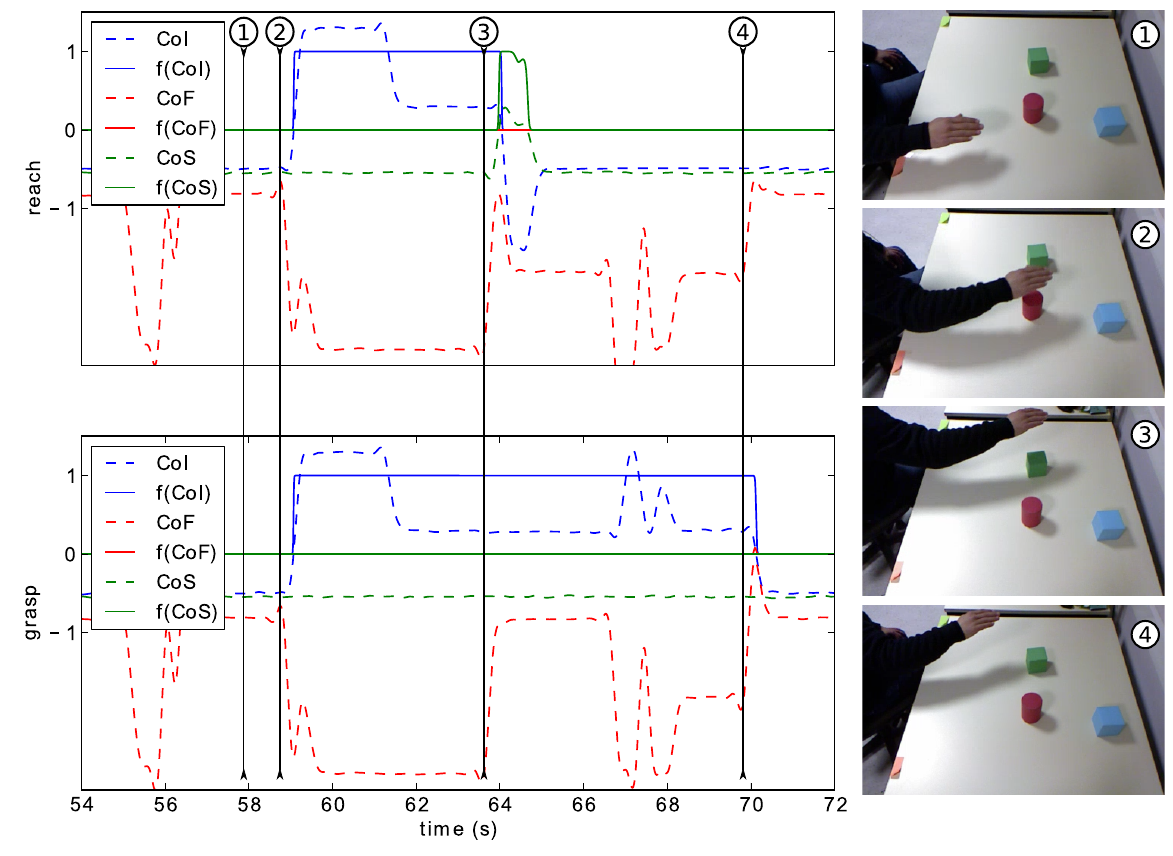
Figure 10: Detection of a failed grasping